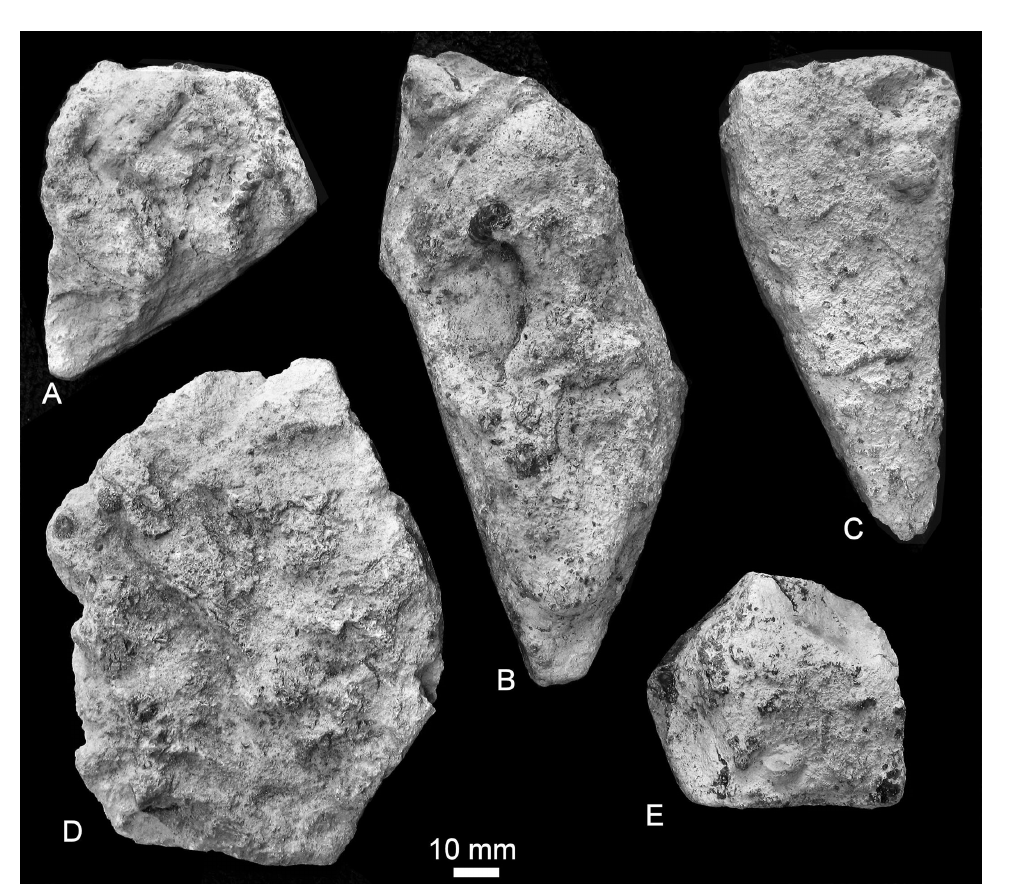
Fig. 5. Boulders of baksteenkalk type 2C: A, RGM 1317637, Wilsum; B, RGM 1317638, Wilsum; C, RGM 1317639,